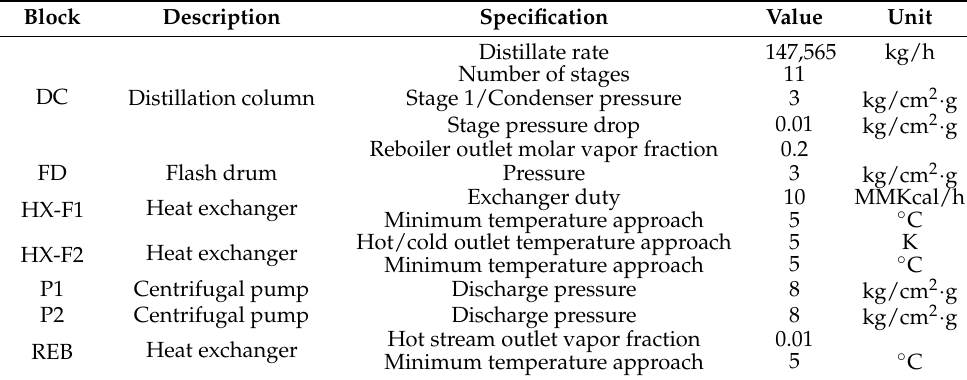
Figure 1. Simplified diagram of conventional evaporation process model using SEE. Table 1. Specifications of conventional process model.